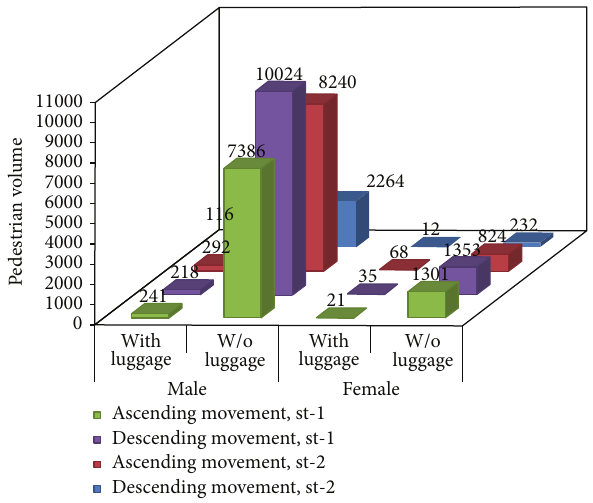
Figure 6: Genderwise distribution of pedestrian movement consid- ering luggage